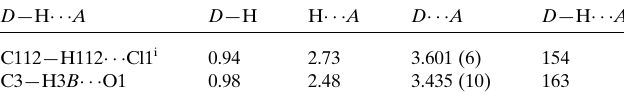
Table 3 Hydrogen-bond geometry (A˚ , (cid:3) ) for 2